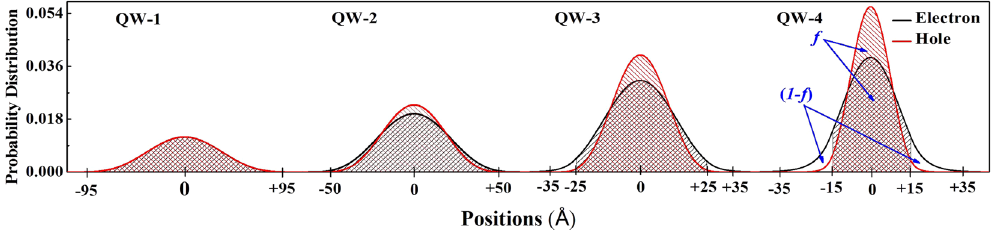
Figure 4. Spatial extent of electron/hole wave function computed by solving Schrödinger equation in FDM technique. Probability of finding an electron/hole in QW layer ( f ) and barrier layer ( 1 − f ) are estimated numerically.